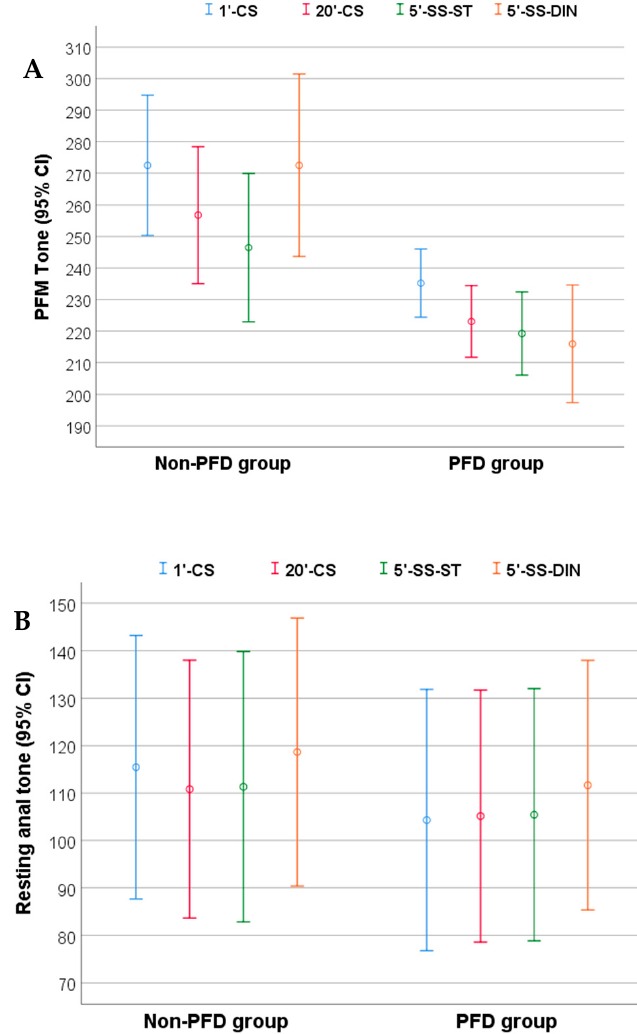
Figure 3. Pelvic floor muscle tone ( A ) and resting anal tone ( B ) throughout single 5P ® LOGSURF session. PFM: Pelvic floor muscle; PFD: Pelvic floor dysfunction; CS: Static phase on the convex side; SS-ST: Static phase on the surf side; SS-DIN: Dynamic phase on the surf side. Deep abdominal muscle electrical activity increased throughout single 5P ®